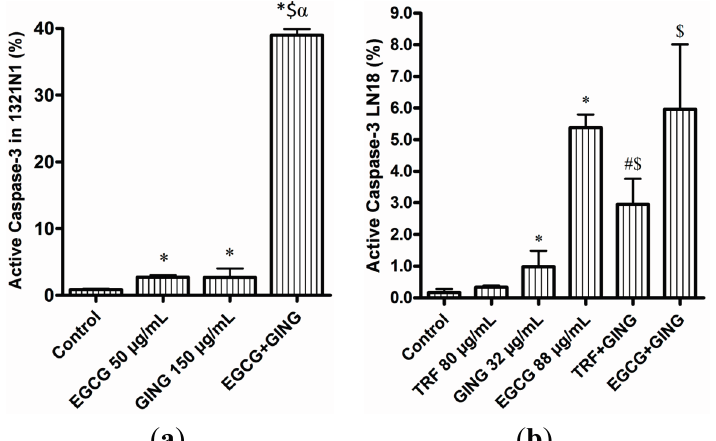
Figure 3. Combined compounds caused greater inhibition of growth of ( a ) 1321N1 and ( b ) LN18 cells than either agent alone, as evidenced by the presence of active caspase-3. Each value represents the mean ± SD of three independent